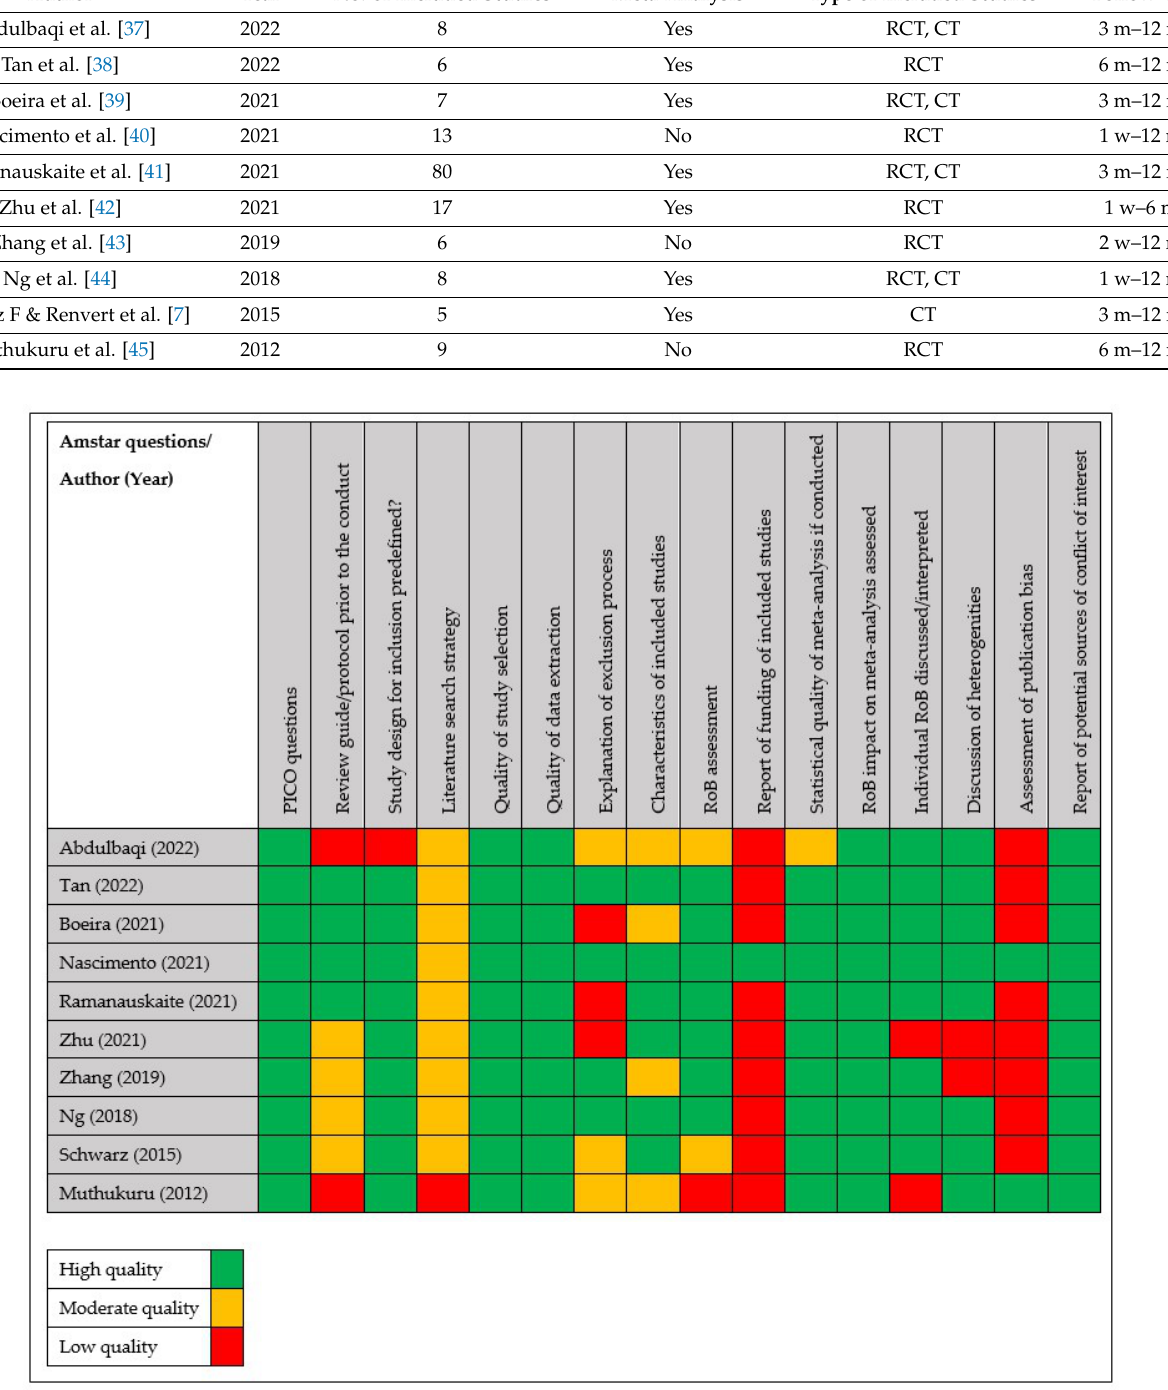
Table 1. Characteristics of the included studies (CT: controlled clinical trial; m: month; RCT: random- ized controlled trial; w: week).